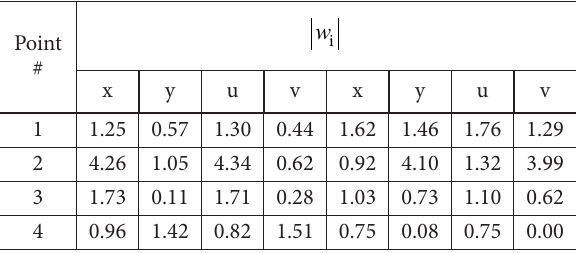
Table 5. The absolute value of the test statistic w i for each of the measurements with gross error in the (x, y) coordinate system